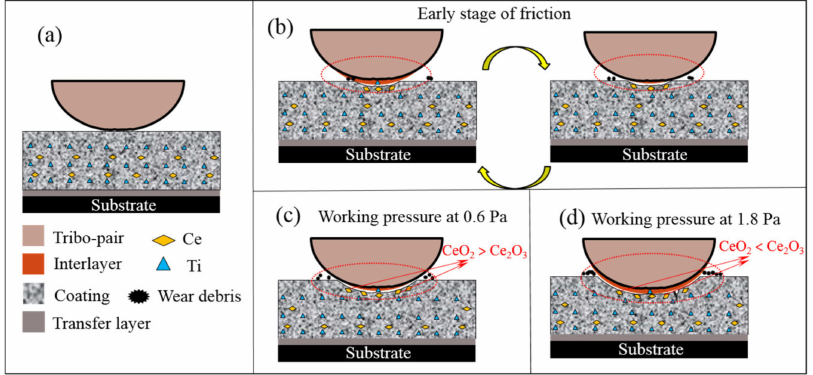
Figure 12. Wear mechanisms for Ce-Ti/MoS 2 coatings sliding against 9Cr18 balls. ( a ) is the stage before the beginning of friction, ( b ) is the early stage of friction. After a certain friction time, ( c ) is the friction state at 0.6 Pa, ( d ) is the friction state at 1.8